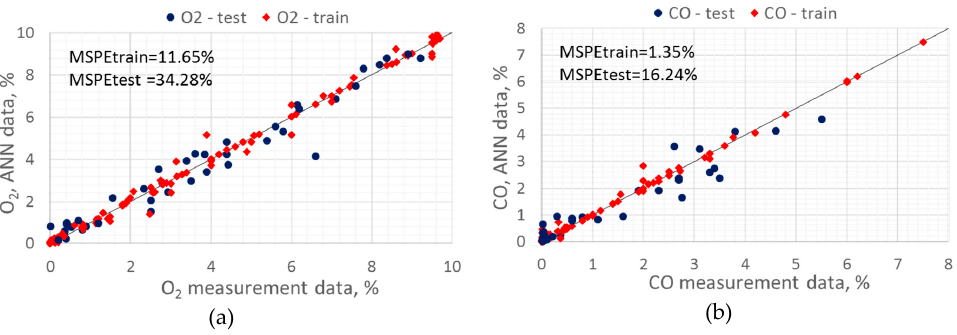
Figure 6. ANN results for training (red) and testing (blue) for O 2 and CO concentration predictions (( a , b ), respectively); solid lines for man